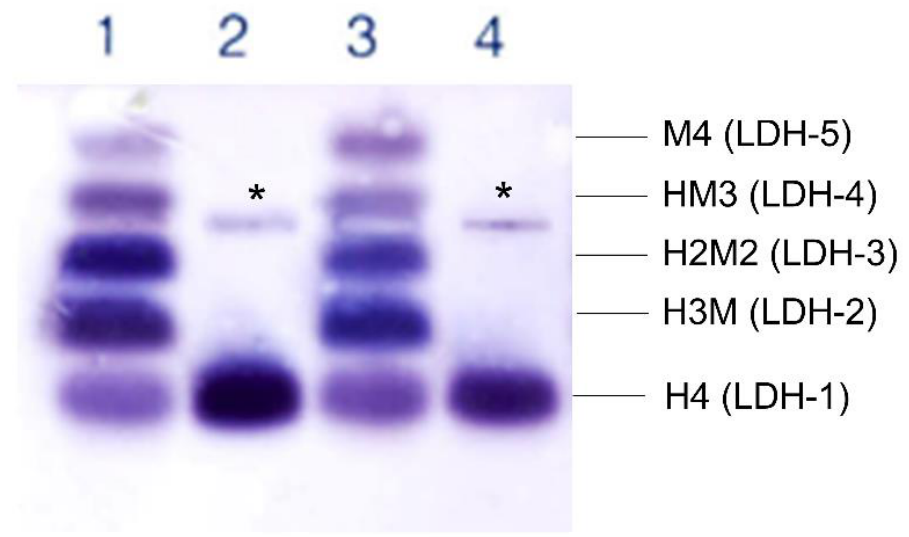
Figure 4. Electrophoretic separation of lactate dehydrogenase isoenzymes was obtained from plasma of two healthy controls (lanes 1 and 3), the index case of Family 1 (lane 2), and the index case of Family 2 (lane 4). Only one band of LDH-1 (H4) isoenzyme with the fastest mobility to the anodic side was present in both index cases. * mark caused by loading the sample. Table 1. Serum lactate dehydrogenase (LDH) and creatine kinase (CK) basal levels from index cases of both families.